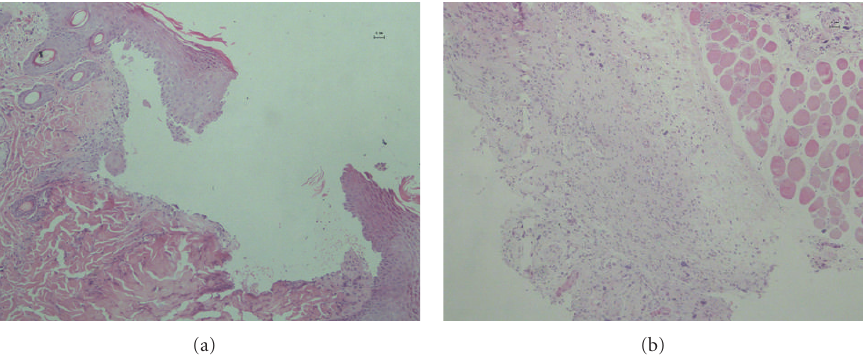
Figure 4: Photomicrograph of tissue samples from 20 mW/cm 2 group (a) and control group (b) at 8 days after wounding (HE stain × 100).